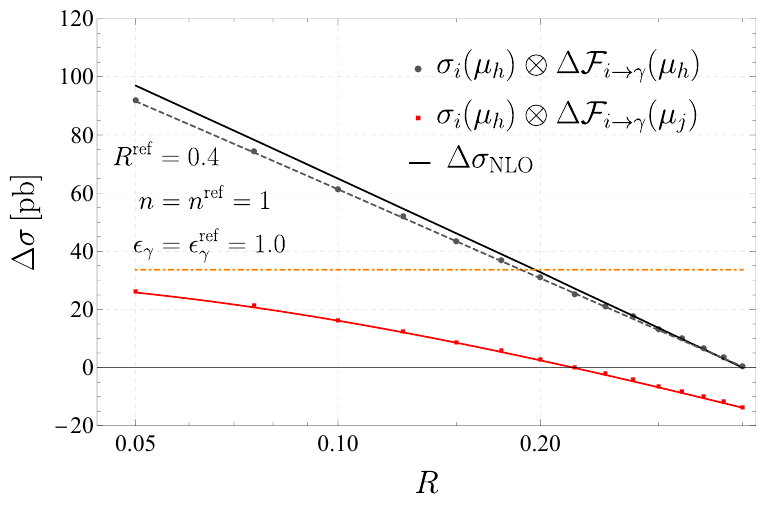
Figure 9 . Effect of ln( R ) resummation, plotted as the difference to the fixed-order cross section at R ref = 0 . 4 . Shown are the resummed result (red) and its fixed-order expansion (dashed) obtained by setting µ j = µ h . We also show the full fixed-order result (black) evaluated with µ r = µ f = µ h , which also includes terms which are power suppressed in R . Above the orange dot-dashed line, the cross section with isolation becomes larger than the inclusive cross section, which is